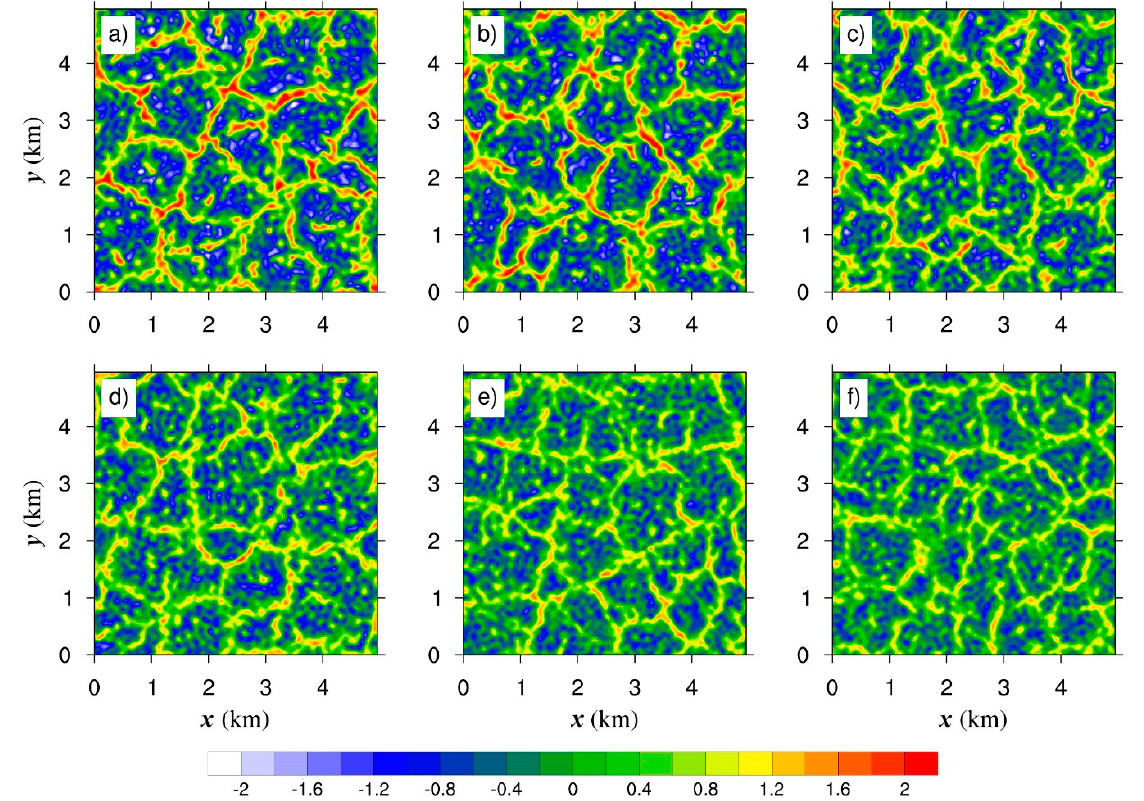
Figure 2. Horizontal ( x – y ) slices of the vertical velocity at a dimensionless height of z / z i = 0.1 ( z is the height above the ground, z i is boundary layer depth) averaged over 200 time-steps (about 6–7 min) for the cases of ( a ) control case (CTL) with AOD = 0; ( b ) aerosol case (A03), AOD = 0.3; ( c ) aerosol case (A06), AOD = 0.6; ( d ) aerosol case (A09), AOD = 0.9; ( e ) aerosol case (A12), AOD = 1.2; and ( f )